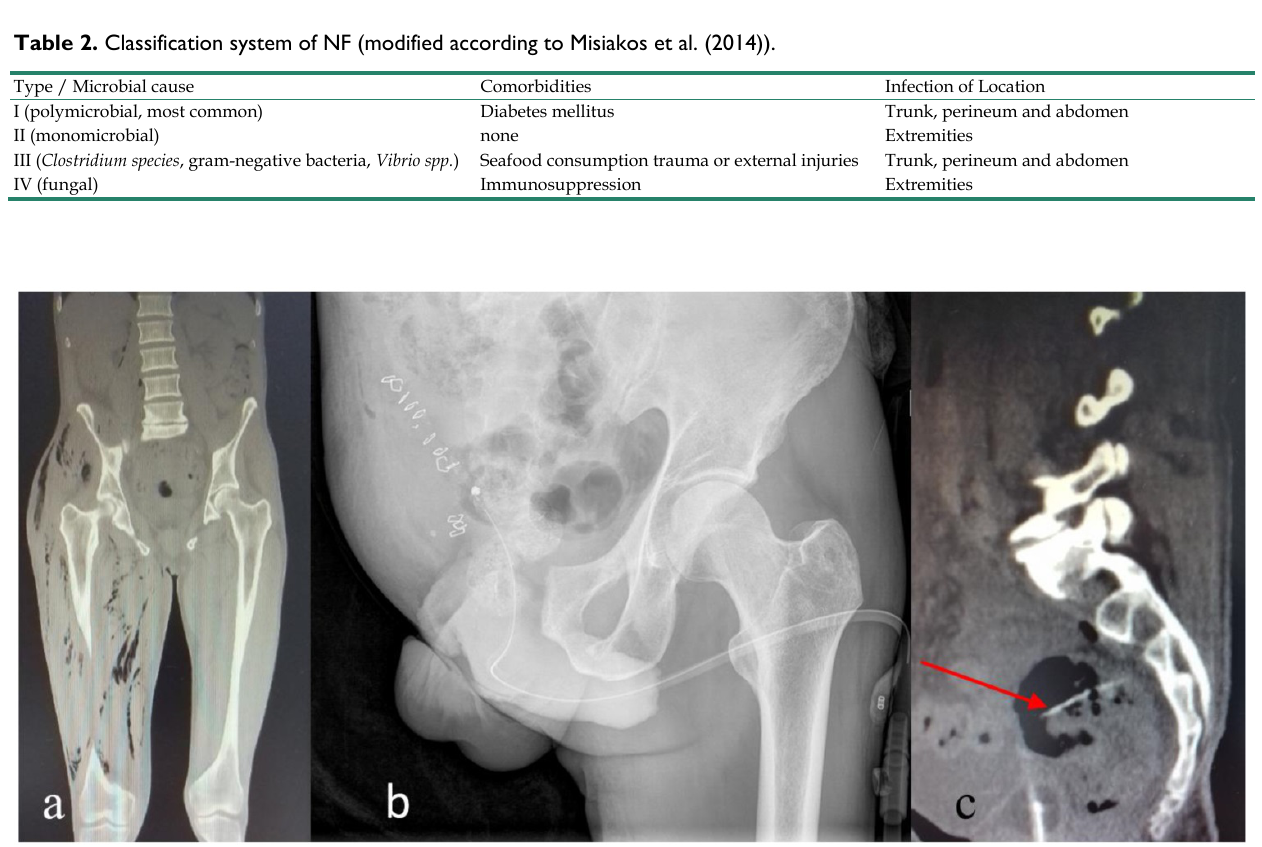
Figure 1. (a) CT scan prior to admission to our hospital. The coronal view shows retroperitoneal gas formation along the right iliopsoas muscle and all compartiments of the right thigh. (b) Postoperative X-ray control after right-sided hemipelvectomy. (c) The sagittal CT section of the abdomen and pelvis shows an acicular foreign body of 6cm length in the upper